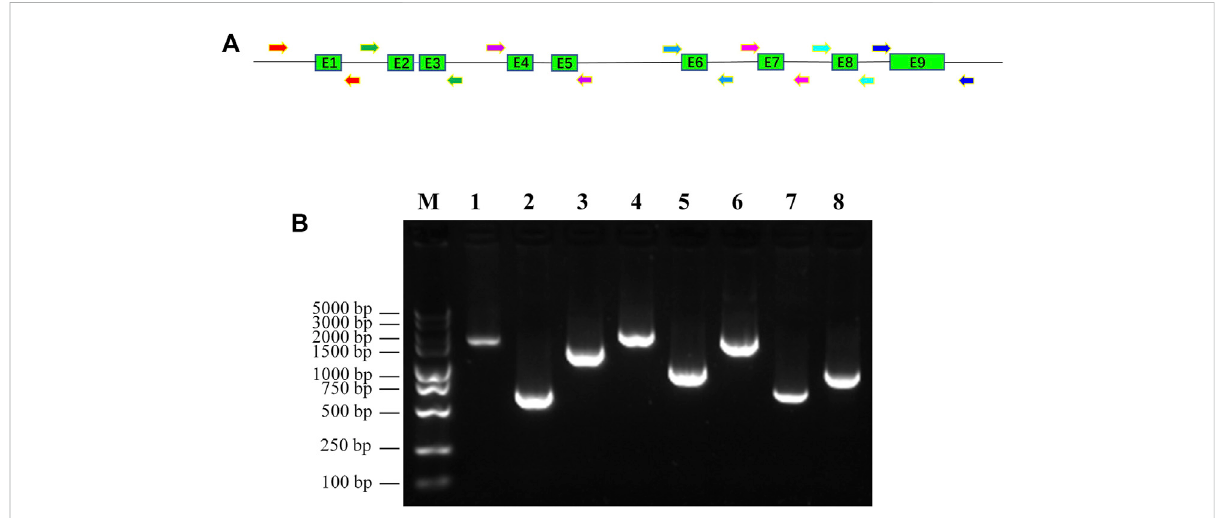
FIGURE 1 Ampli fi cationofpromoterregionandexonsofhuman CYP2C9 genewithnewlydesignedPCRprimers. (A) :Diagramofnewlydesignedprimers and genomic structure of human CYP2C9 gene. Shaded boxes represent the exons and lines indicate the promoter region and introns. Arrowheads indicate the primers that used for the PCR ampli fi cation. (B) : Gel picture of PCR amplicons of CYP2C9 promoter and exons. M: DNA molecular standard; 1: promoter region; 2: exon1; 3: exon2+exon3; 4: exon4+exon5; 5: exon6; 6: exon7; 7: exon8; 8: